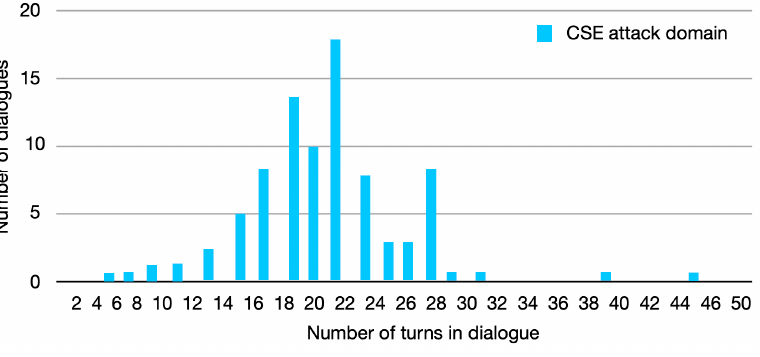
Figure 4. Distribution of turns in the SG-CSE Corpus.